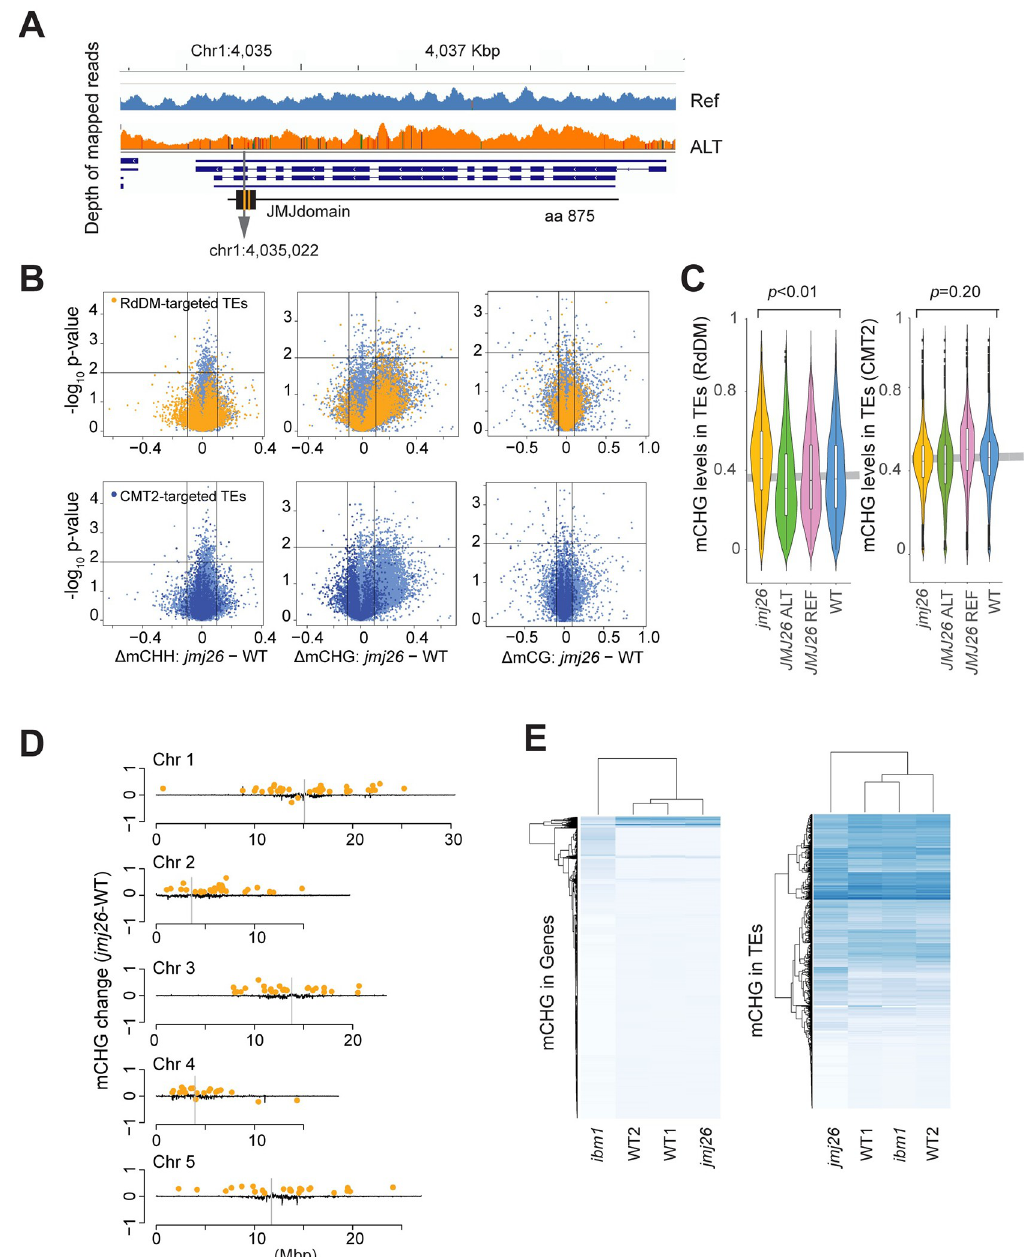
Fig 5. Effects of JMJ26 on mCHG levels. (A) Read density and SNP across the gene model. (B) Volcano plots showing the effects on DNA methylation levels of jmj26 on RdDM- and CMT2-targeted transposons. (C) Violin plots showing the distribution of mCHG levels of RdDM- and CMT2-targeted transposons in WT (Col-0), jmj26 , and two lines with JMJ26 ref or JMJ26 alt transgenes in Col-0 jmj26 background. The gray horizontal line shows the mean value of WT. (D) The genome-wide distribution of transposons affected by JMJ26 . Black lines show differential mCHG levels of jmj26 from Col-0 in 30 kbp sliding windows. Orange dots show transposons with significantly changed mCHG levels ( n = 2, p < 0.01 by two-tailed Welch’s t -test & differential mCHG > 0.1 or < -0.1). (E) Heat map comparing JMJ26 and IBM1 targets. Rows correspond to standardized mCHG levels in each gene or transposon for jmj26 , ibm1 , and